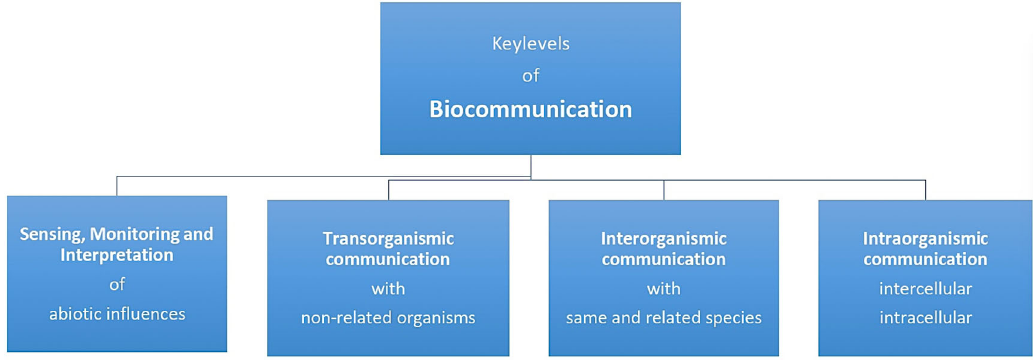
Figure 2. The biocommunication approach identified four levels of rule-governed and sign-mediated inter- actions in which cellular organisms are involved throughout their lives (from Witzany,